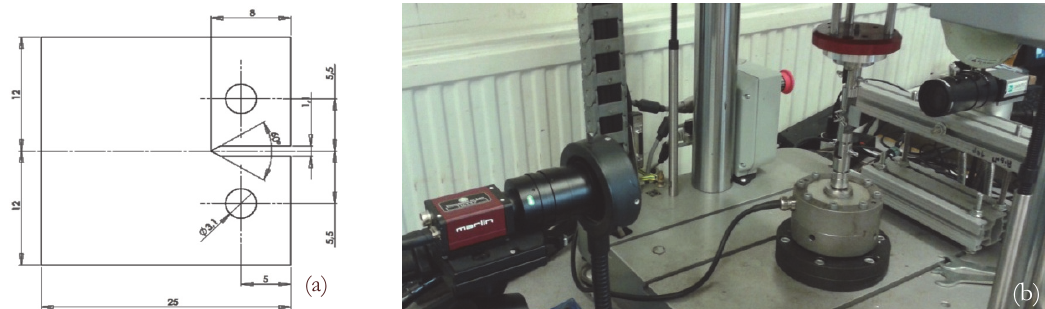
Figure 1: (a) Dimensions (mm) of the CT specimen tested. (b) Experimental set-up used to measure DIC data during fatigue